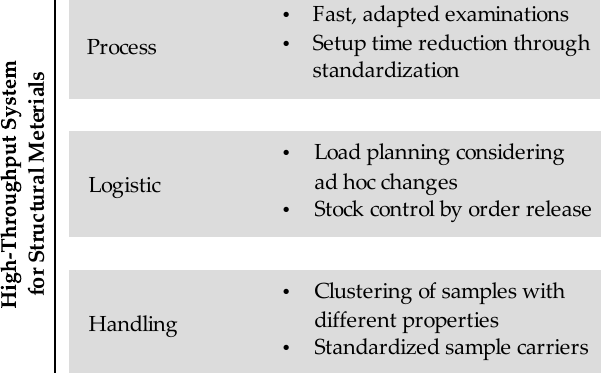
Figure 4. Framework for high-throughput system acceleration.